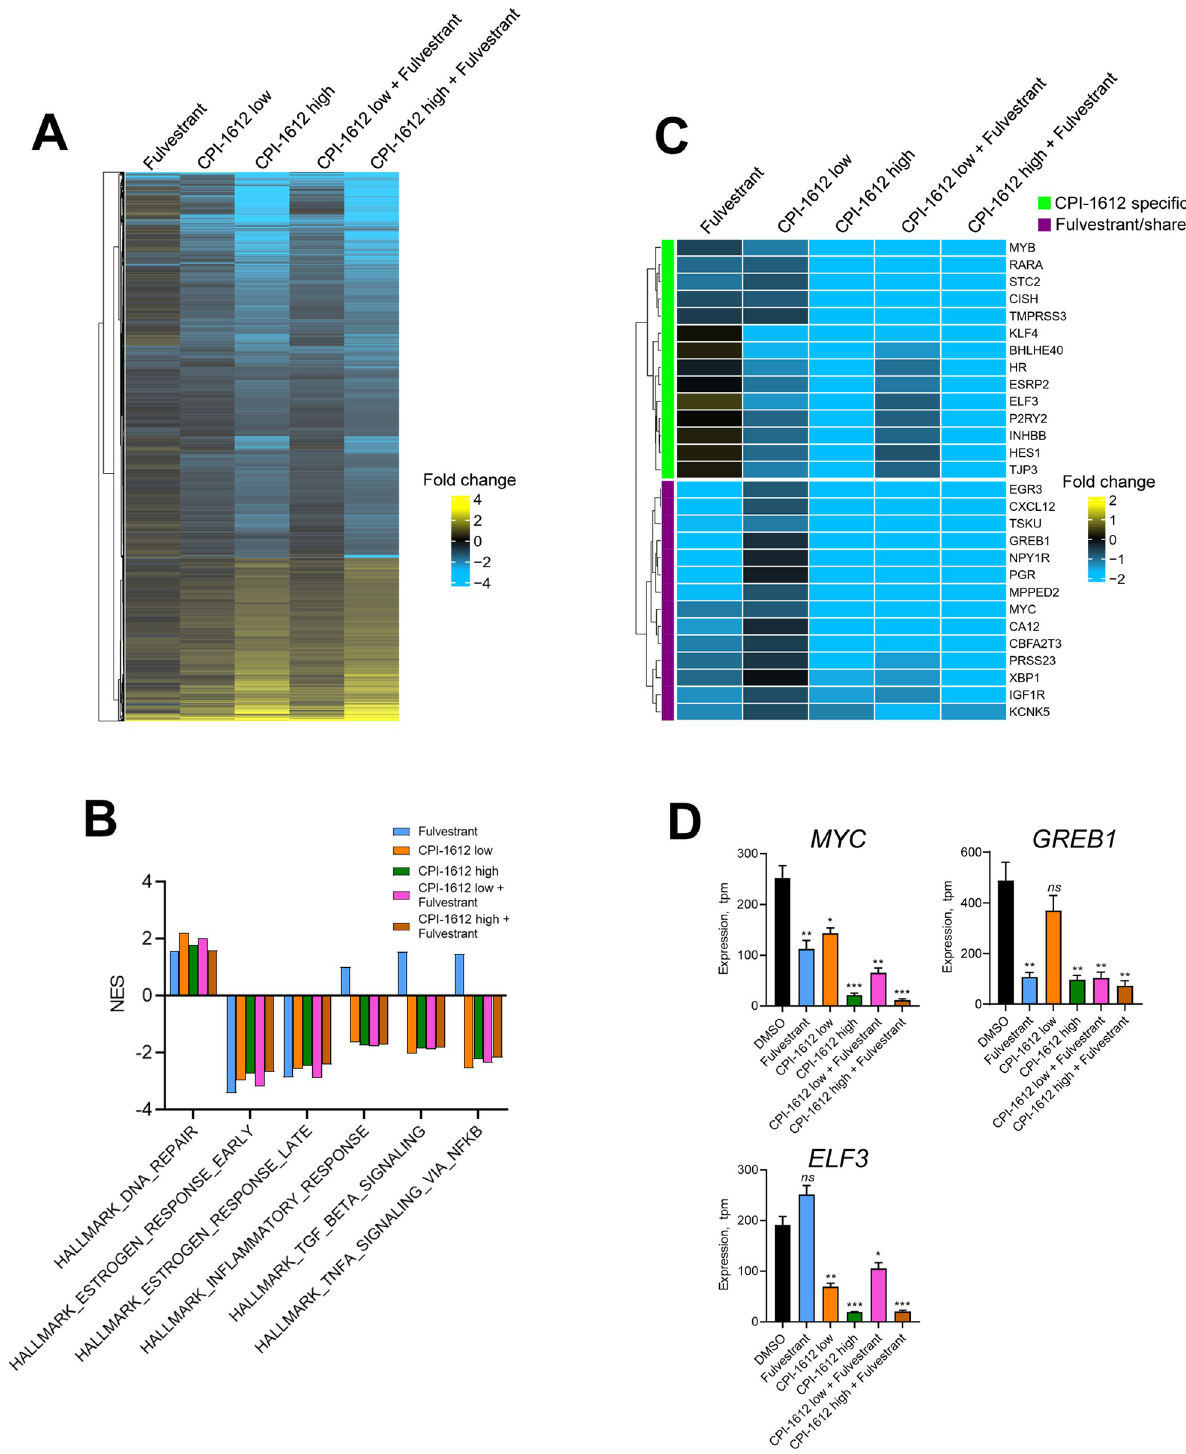
Fig 2. CPI-1612 inhibits the ER transcriptional program. (A) Bulk RNA-seq analysis of MCF7 cells. MCF7 cells were treated as indicated for 6 hours (n = 3 per treatment) followed by isolation of mRNA for RNA-sequencing analysis. Differential expression is indicated as log 2 (fold-change) in normalized counts relative to the DMSO control. Genes shown were modulated at least 1.5-fold in at least one condition. Concentrations used were CPI-1612 low: 5 nM; CPI-1612 high: 50 nM; Fulvestrant: 100 nM. (B) CPI-1612 has a distinct transcriptional effect from Fulvestrant. Gene Set Enrichment Analysis (GSEA) was carried out using the MSigDB Hallmark genesets with the data described in (A). Normalized enrichment scores